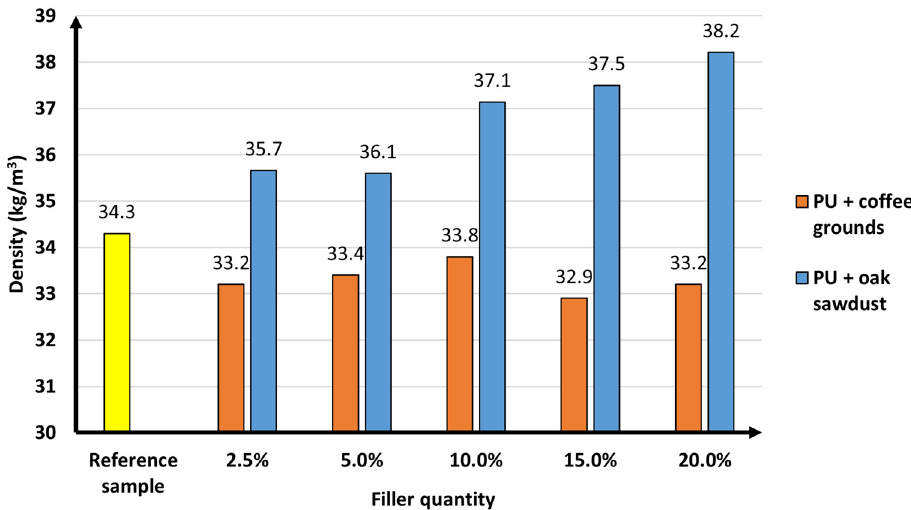
Figure 4. Free density of standard sample and polyurethane composites ( ± 0.5 kg/m 3 ). The free density of the reference sample was 34.3 kg/m 3 . The free density of rigid foams with the addition of coffee grounds ranged from 33.2 to 33.8 kg/m 3 , while for sawdust filled samples, it ranged from 35.6 to 38.2 kg/m 3 .